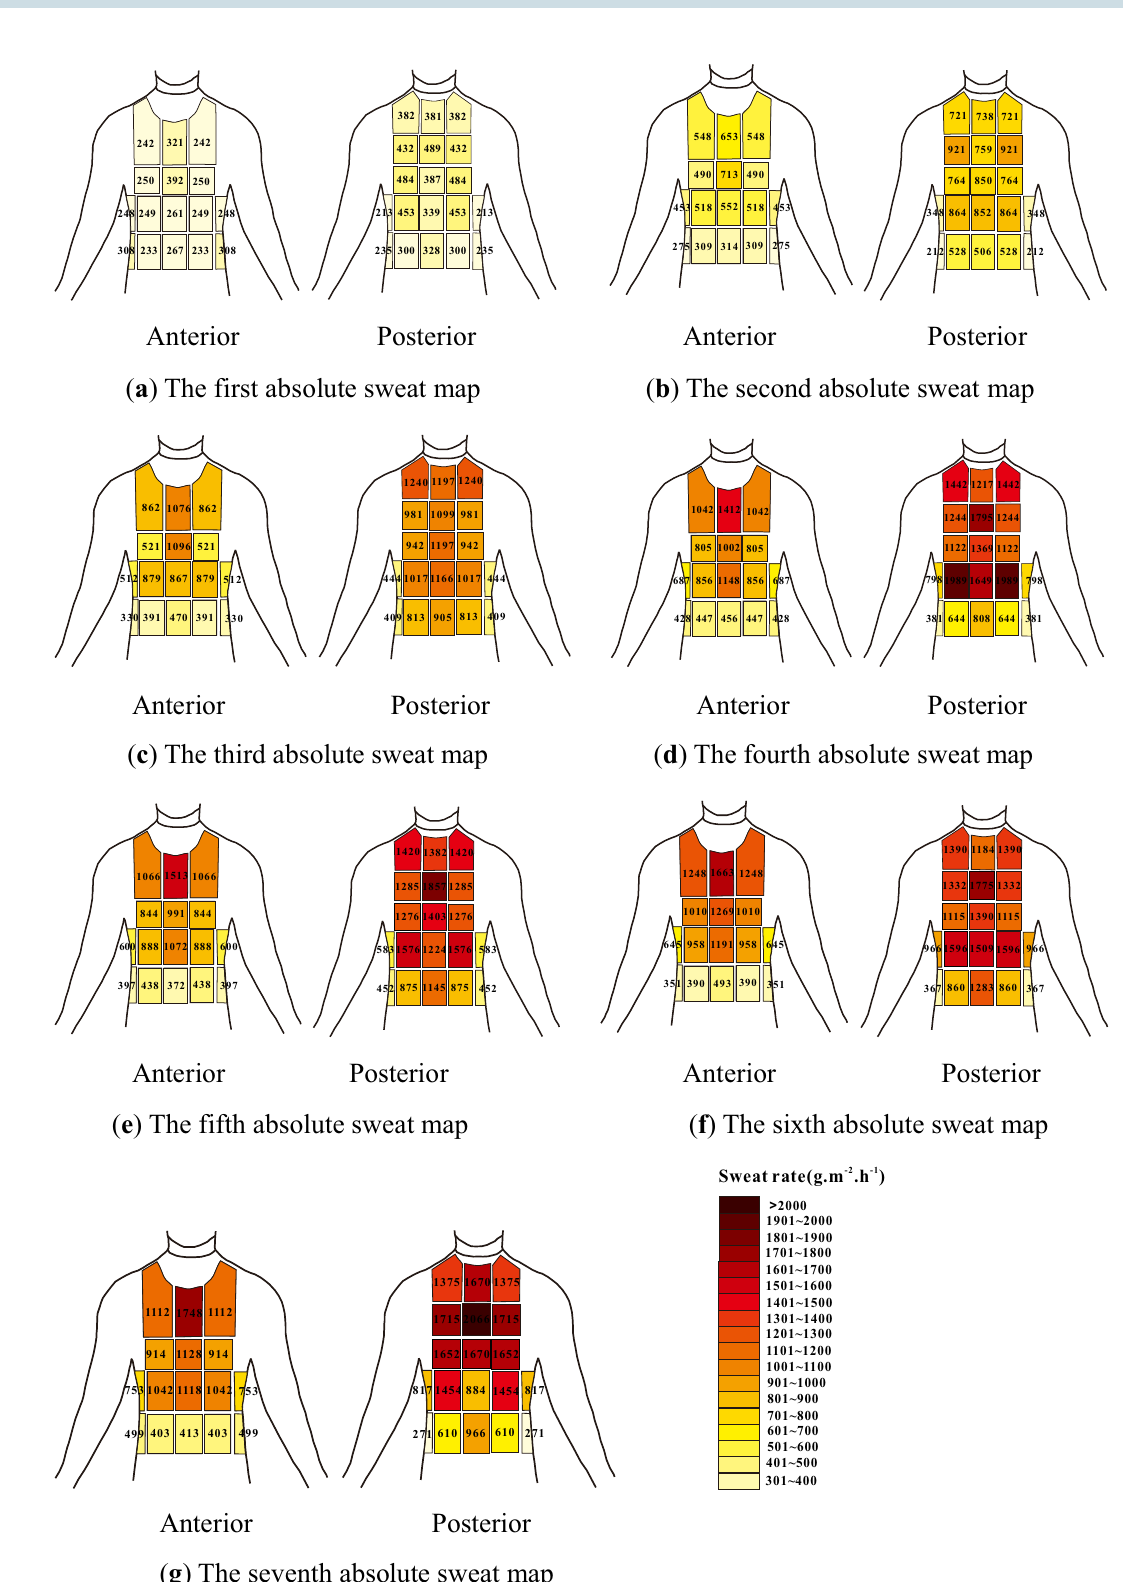
Figure 5. Absolute RSR of participants wearing FCPE. Figures were created using Coreldraw Version (21.0.0.593). ( a ) The first absolute sweat map was drawn based on sweat of upper body collected for 0–5 min. ( b ) The second absolute sweat map was drawn based on sweat of upper body collected for 9-14 min. ( c ) The third absolute sweat map was drawn based on sweat of upper body collected for 18–23 min. ( d ) The fourth absolute sweat map was drawn based on sweat of upper body collected for 27–32 min. ( e ) The fifth absolute sweat map was drawn based on sweat of upper body collected for 36-41 min. ( f ) The sixth absolute sweat map was drawn based on sweat of upper body collected for 45–50 min. ( g ) The seventh absolute sweat map was drawn based on sweat of upper body collected for 54–59 min. Figure 6 Relative regional sweat rates of participants wearing